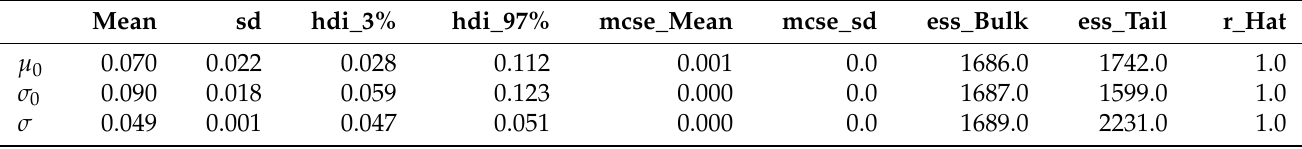
Table 1. Hyper-prior parameters of the current spline model are efficiently estimated. They get very thin distributions centered in the neighborhood of zero. Standard error of the current measurement is estimated at 0.05 kA which is consistent with simulations. Probabilistic computation is efficient, as Monte Carlo standard error (MCSE) is vanishingly small. Effective sample size of both bulk of distribution and its tails is on the level of 42% (total numnber of samples is 4000) what is a reasonable